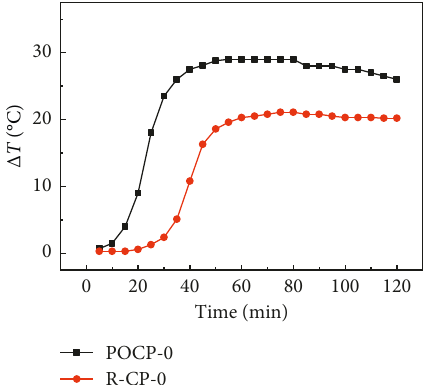
Figure 6: Temperature evolution rate curves of R-CP-0 and POCP-0.